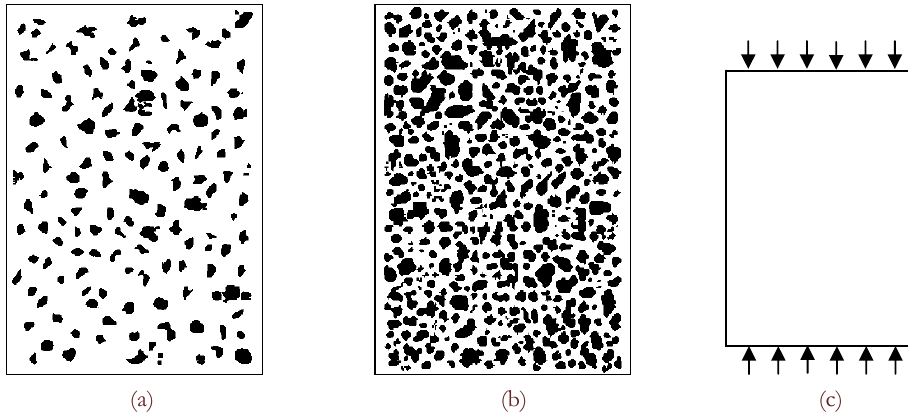
Figure 1: The model specimens of composites with 15% (a) and 40% (b) content of the hardening particles and the principle loading scheme (c).